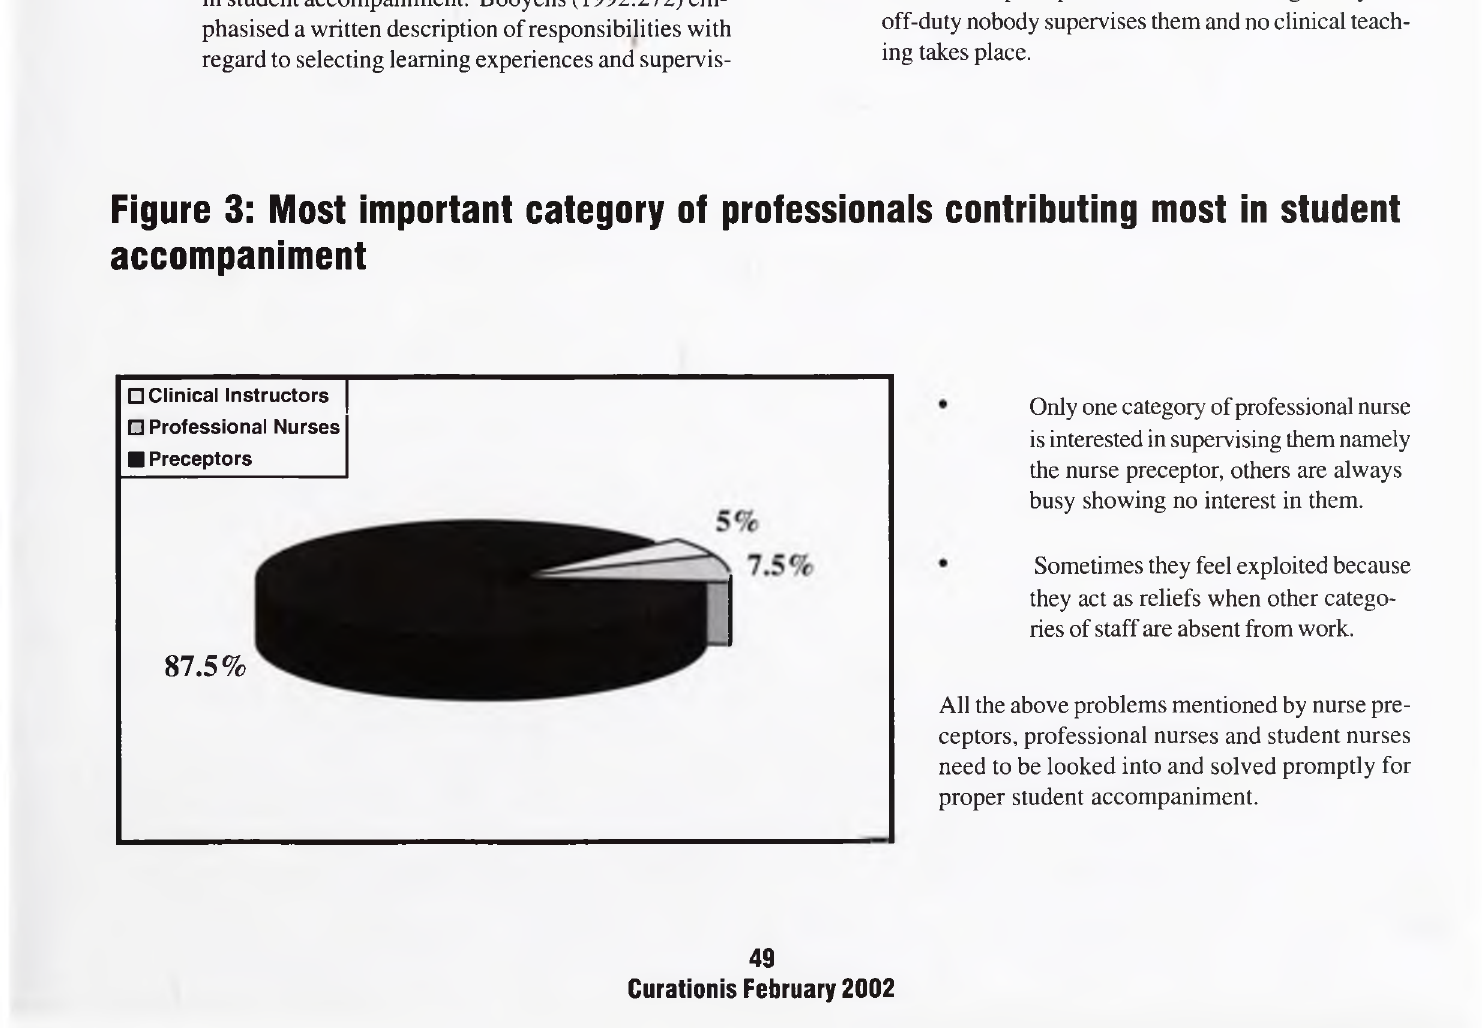
Figure 3: Most important category of professionals contributing most in student